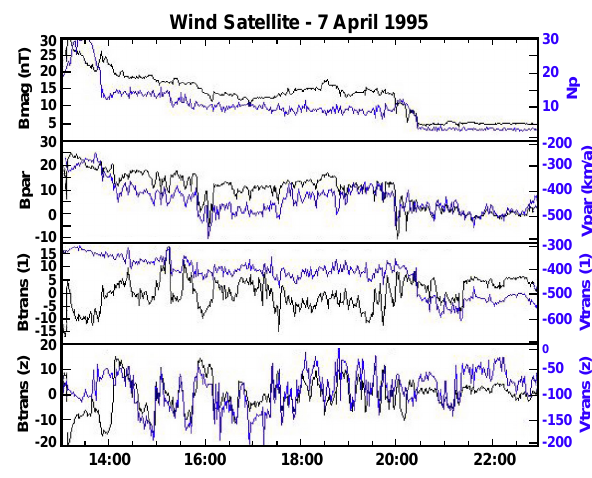
Fig. 5. Wind data in the solar wind inside the compression region, 7 April 1995. Top panel: magnetic field and density; second panel: b || and v || , bottom two panels: transverse components of b and v .